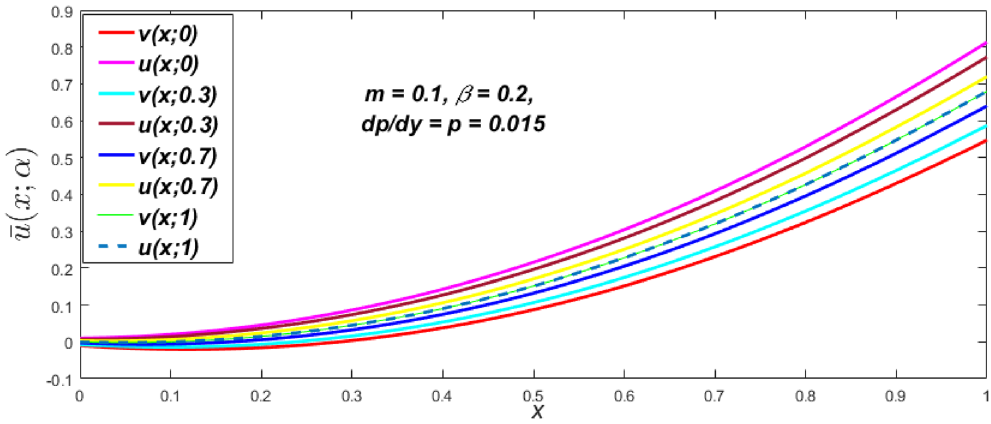
Figure 40. Fuzzy velocity for numerous values of α -cut.